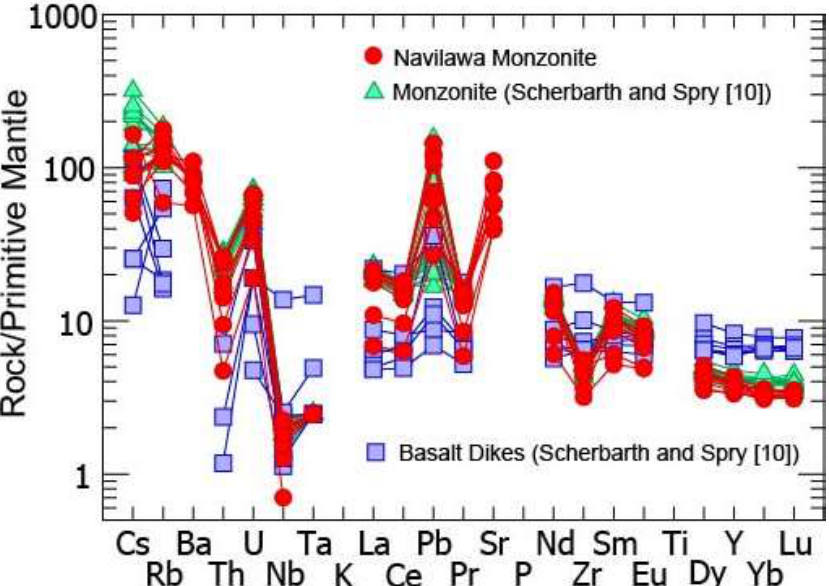
Figure 7. Mantle-normalized trace element patterns for Navilawa Monzonite. Data from Navilawa Monzonite and basaltic–andesite dikes from the Tuvatu prospect are from Scherbarth and Spry [10]. Normalization values are from Sun and McDonough [49]].